Question: Write the caption for this figure.
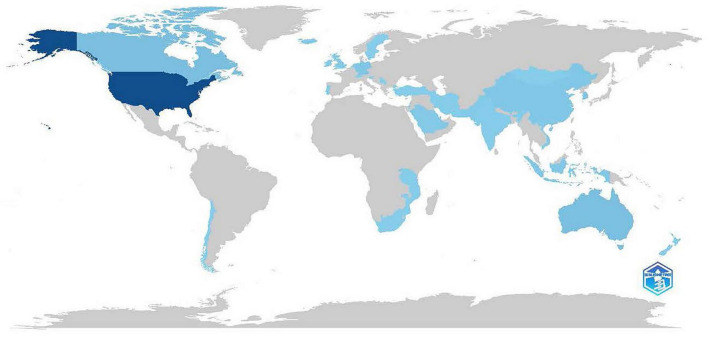
Answer: Country scientific production. Global distribution of publications in faculty development research showing countries contributing to the field, with darker shading representing higher publication output.